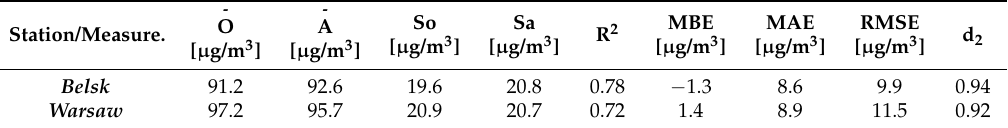
Table 3. Statistical performance of the neural network models for data set from 2015. maximum observed and predicted concentration ( µ g/m 3 ), respectively; So and Sa—standard deviation of observed and predicted concentration ( µ g/m 3 ), respectively; R 2 —coefficient of determination; MBE—mean bias error ( µ g/m 3 ); MAE—mean absolute error ( µ g/m 3 ); RMSE—root mean square